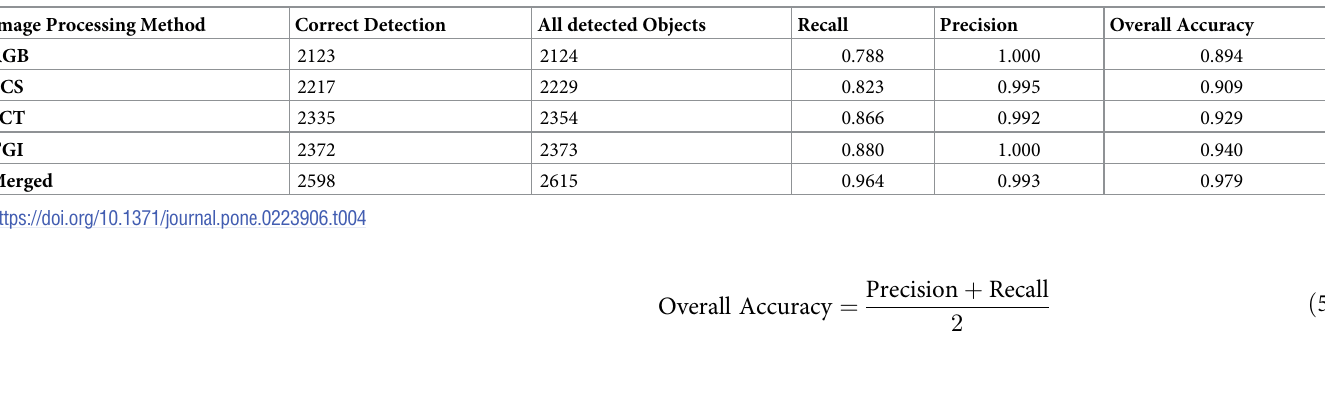
Table 4. Detection performance on ROI of 40m altitude variant.